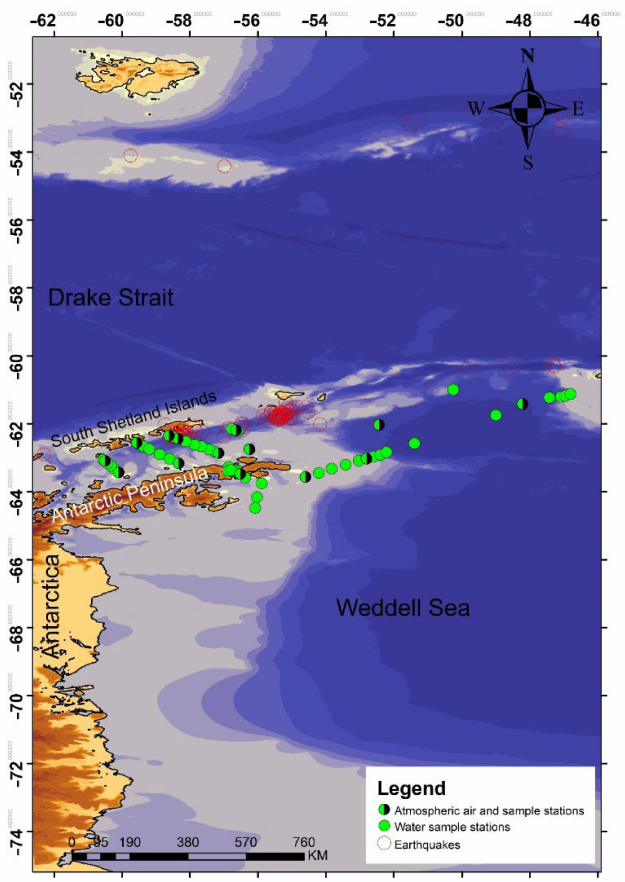
Figure 1. A map of sample stations, 87th cruise of R/V “Academik Mstislav Keldysh” (7 December 2021–5 April 2022) and earthquakes for 2020 year according to